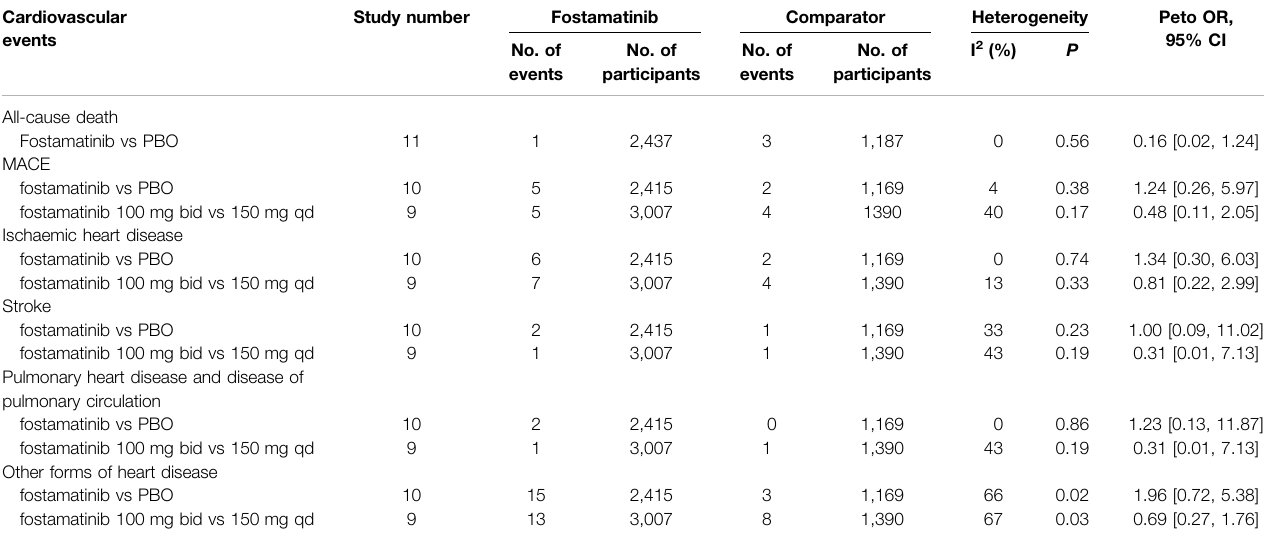
TABLE 2 | Pooled data of cardiovascular adverse events in RA patients.